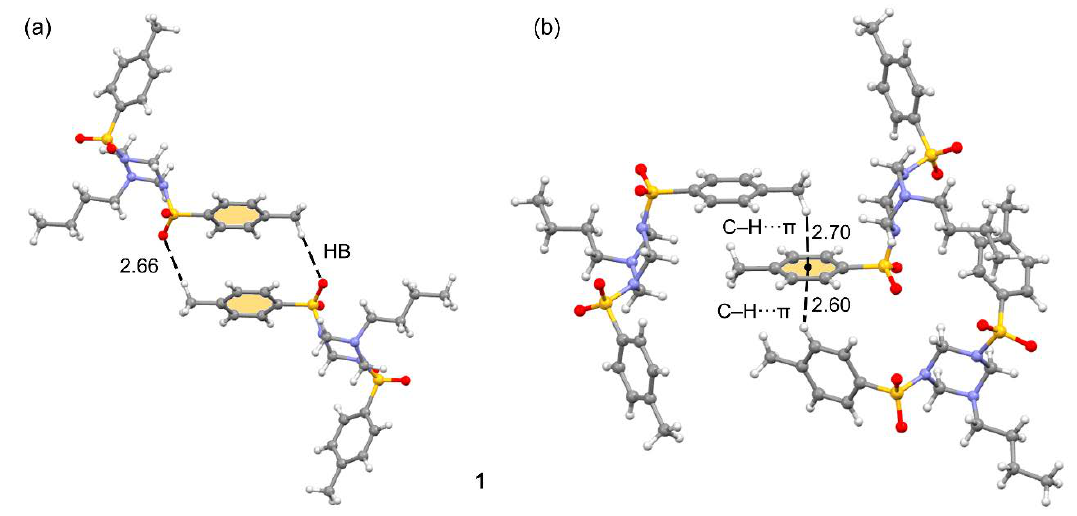
Figure 2. ( a ) Self assembled dimer in compound 1 . ( b ) C–H ··· π ··· H–C assembly in the solid state of structure 1 . Distances in Å. For the C–H ··· π interactions, the distances are measured from the H-atom to the ring centroid.